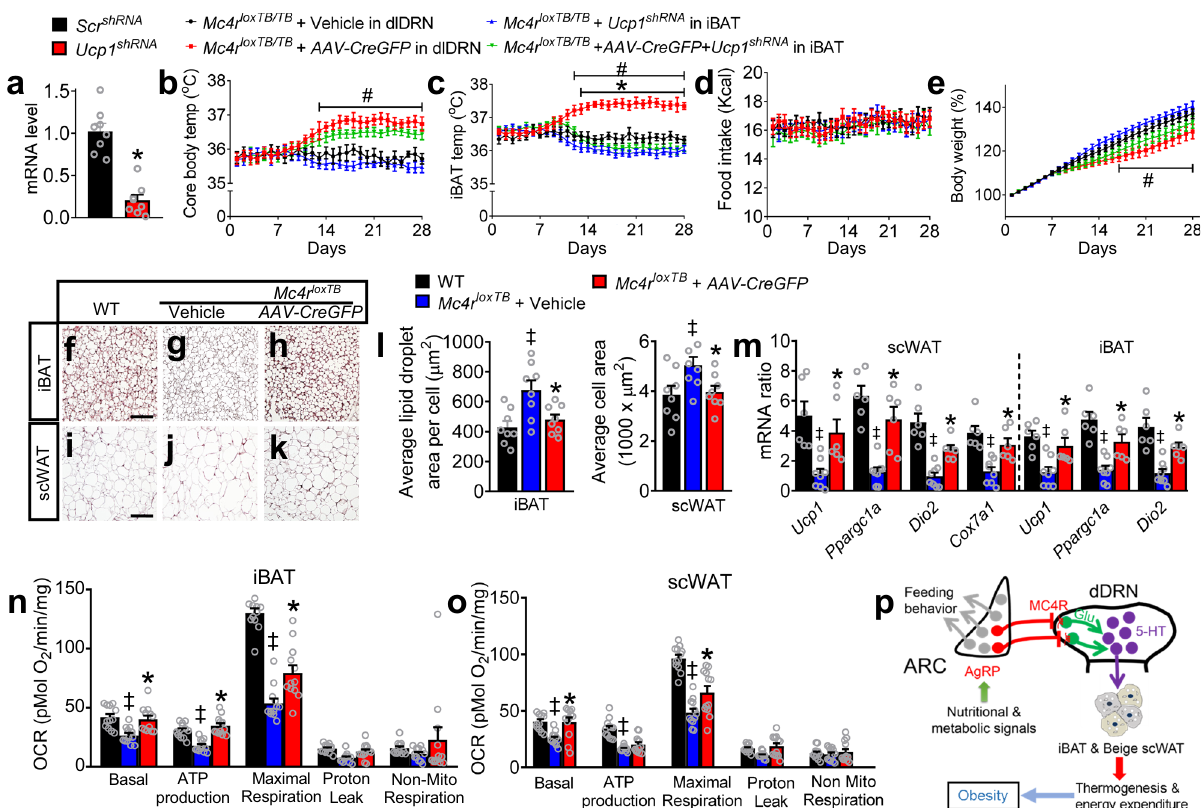
Fig. 6 The AgRP ARC → MC4R dlDRN → 5-HT dmDRN neural circuit mediates thermogenesis through brown and beige adipose tissues. a The expression pro fi le of Ucp1 in the iBAT was analyzed by qRT-PCR 4 weeks after injection of the lentivirus expressing UCP1 shRNA or control SCR shRNA into the iBAT ( n = 8 per group; F = 2.160, * P < 0.0001; unpaired two-tailed t test). b – e Core body temperature ( b ), iBAT temperature ( c ), food intake ( d ), and body weight ( e ) monitored for 4 weeks in the mice described in a ( n = 8 per group; * P was calculated between AAV2-CreGFP and AAV2-CreGFP + Ucp1 shRNA , # P was calculated between vehicle and AAV2-CreGFP ; for b , F = 130.0, # P < 0.0001; for c , F = 264.8, *P < 0.0001, # P < 0.0001 ; for e , F = 88.89, # P = 0.0002; two- way ANOVA followed by Bonferroni post hoc test). f – k Representative HE staining of the iBAT ( f – h ) and scWAT ( i – k ) from 14- to 16-week-old WT, Mc4r loxTB mice with vehicle ( AAV2-GFP ) or AAV2-CreGFP injected into the dlDRN. Scale bar in f and i for f – h and i – k , 50 µ m. l Average lipid droplet area in iBAT and adipocyte area in scWAT in mice described in f – k ( n = 8 per group; *P was calculated between Mc4r loxTB + vehicle and Mc4r loxTB + AAV2- CreGFP , ‡ P was calculated between Mc4r loxTB + vehicle and WT; for left panel: F = 7.218, *P = 0.0277, ‡ P = 0051; for right panel: F = 2.943, *P = 0 . 0472, ‡ P = 00274; one-way ANOVA followed by Tukey post hoc test). m qRT-PCR pro fi le of key thermogenesis markers in the scWAT and iBAT of the mice described in f – k ( n = 6 in WT and Mc4r loxTB + AAV2-CreGFP group, n = 8 in Mc4r loxTB + vehicle group; *P was calculated between Mc4r loxTB + vehicle and Mc4r loxTB + AAV2-CreGFP , ‡ P was calculated between Mc4r loxTB + vehicle and WT; for scWAT, F = 56.34, *P = 0.0010, ‡ P < 0.0001 in Ucp1 , *P < 0.0001, ‡ P < 0.0001 in Ppargc1a , *P = 0.0445, ‡ P < 0.0001 in Dio2 , *P = 0.0468 , ‡ P = 0.0022 in Cox7a1 ; for iBAT, F = 41.69, *P = 0.0095, ‡ P = 0.0003 in Ucp1 , *P = 0.0049, ‡ P < 0.0001 in Ppargc1a , *P = 0.0097, ‡ P < 0.0001 in Dio2 ; two-way ANOVA followed by Bonferroni post hoc test). n , o Oxygen consumption rate (OCR) for basal respiration, ATP production, maximal respiration, proton leak, and nonmitochondrial respiration are measured in the mice described in f – k . ( n = 12 per group; *P was calculated between Mc4r loxTB + vehicle and Mc4r loxTB + AAV2-CreGFP , ‡ P was calculated between Mc4r loxTB + vehicle and WT; for n : F = 46.56, *P = 0.0392, ‡ P = 0.0165 in basal, *P = 0 . 007, ‡ P = 0.0481 in ATP production, *P < 0.0001, ‡ P < 0.0001 in maximal respiration; for o , F = 53.72, *P = 0.0005, ‡ P = 0.0003 in basal, ‡ P < 0.0001 in ATP production, *P < 0 . 0001, ‡ P < 0.0001 in maximal respiration; two-way ANOVA followed by Bonferroni post hoc test). p A schematic diagram showing a neural circuit, in which a subset of AgRP ARC neurons send inhibitory projections to MC4R dlDRN neurons, which in turn send glutamatergic projections onto postsynaptic 5-HT dmDRN neurons. This neural circuit orchestrates bidirectional control of energy expenditure with an enduring and profound effect against body weight in obesity. Error bars represent mean ±